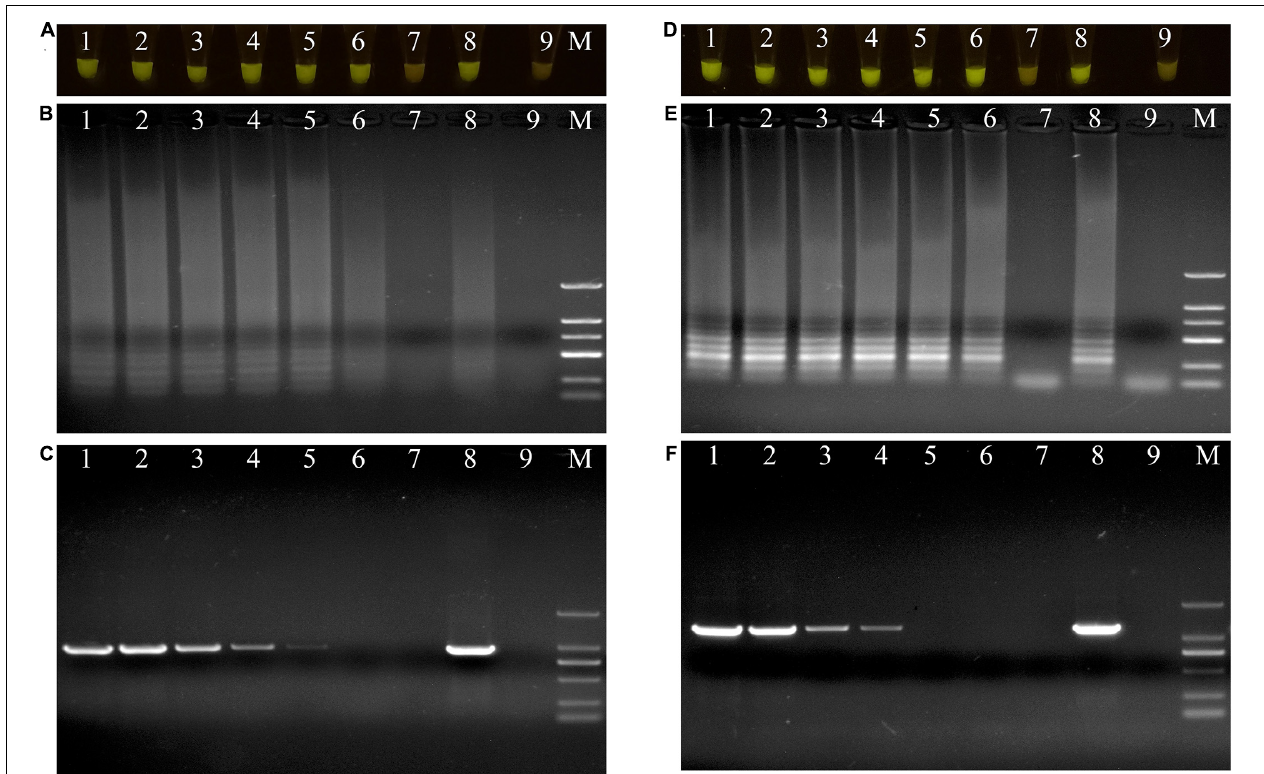
FIGURE 4 | Evaluations of sensitivity of loop-mediated isothermal amplification (LAMP) and polymerase chain reaction (PCR) assay. (A–C) Evaluation of sensitivity of LAMP and PCR assay for Pseudomonas aeruginosa X1. Lane M: DNA marker DL2000; number1–7: DNA at concentrations of 20 ng/ µ L, 2 ng/ µ L, 200 pg/ µ L, 20 pg/ µ L, 2 pg/ µ L, 200 fg/ µ L, and 20 fg/ µ L. number 8: positive control ( Pseudomonas aeruginosa X1). number 9: ddH 2 O. (D–F) Evaluation of sensitivity of LAMP and PCR assay for Serratia marcescens X2. Lane M: DNA marker DL2000; number 1–7: DNA at concentrations of 20 ng/ µ L, 2 ng/ µ L, 200 pg/ µ L, 20 pg/ µ L, 2 pg/ µ L, 200 fg/ µ L, and 20 fg/ µ L. number 8: positive control ( Serratia marcescens X2). number 9: ddH 2 O. (A , D) LAMP products visualized with gelgreen. Under daylight, positive reactions are shown by bright green color, and negative reactions are dark red color. (B , E) Determining the visual LAMP products by agarose